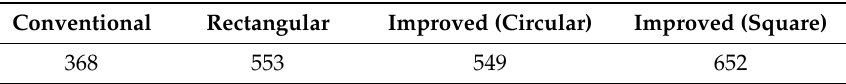
Table 5. Weight of four storage